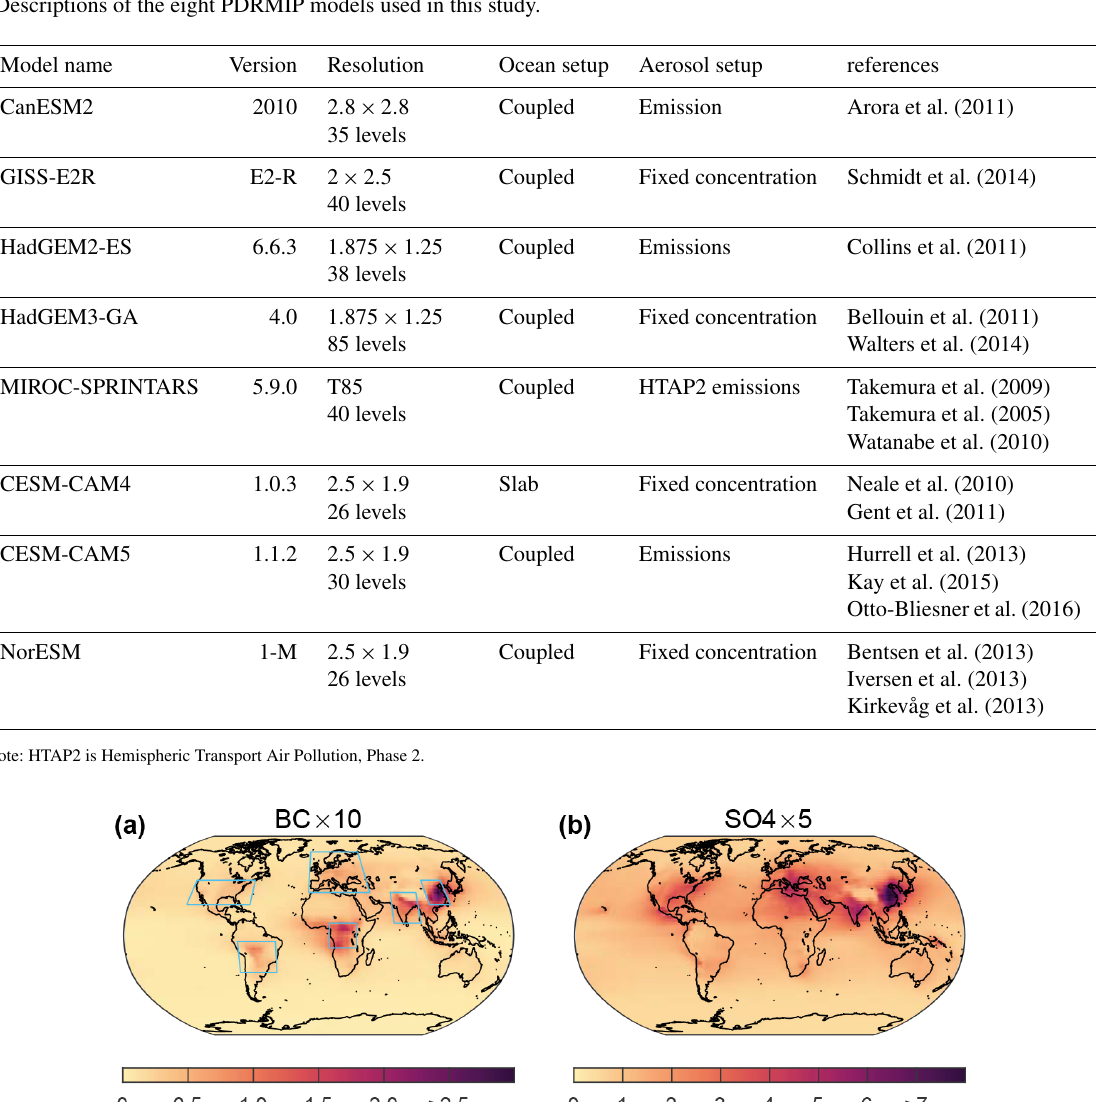
Table 1. Descriptions of the eight PDRMIP models used in this study.